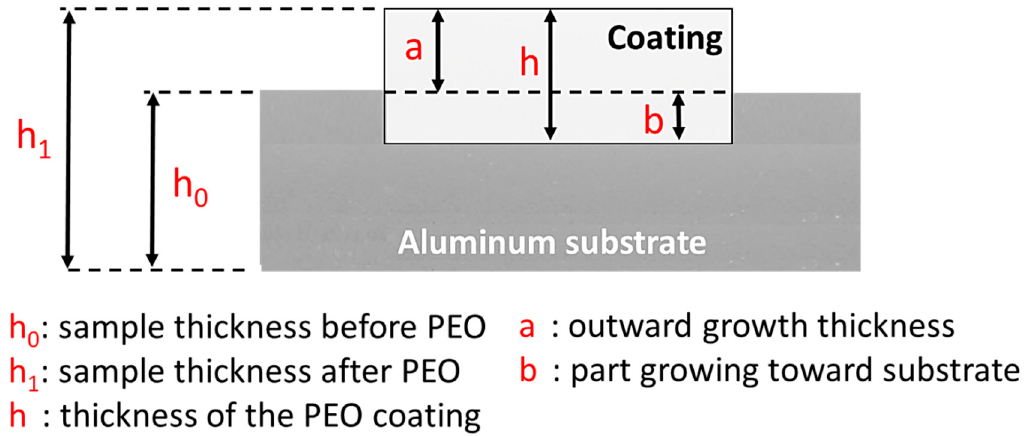
Figure 3. A schematic diagram explaining PEO coating formation on a 1060 Al substrate. Adapted from [40]. Copyright Elsevier, 2020.